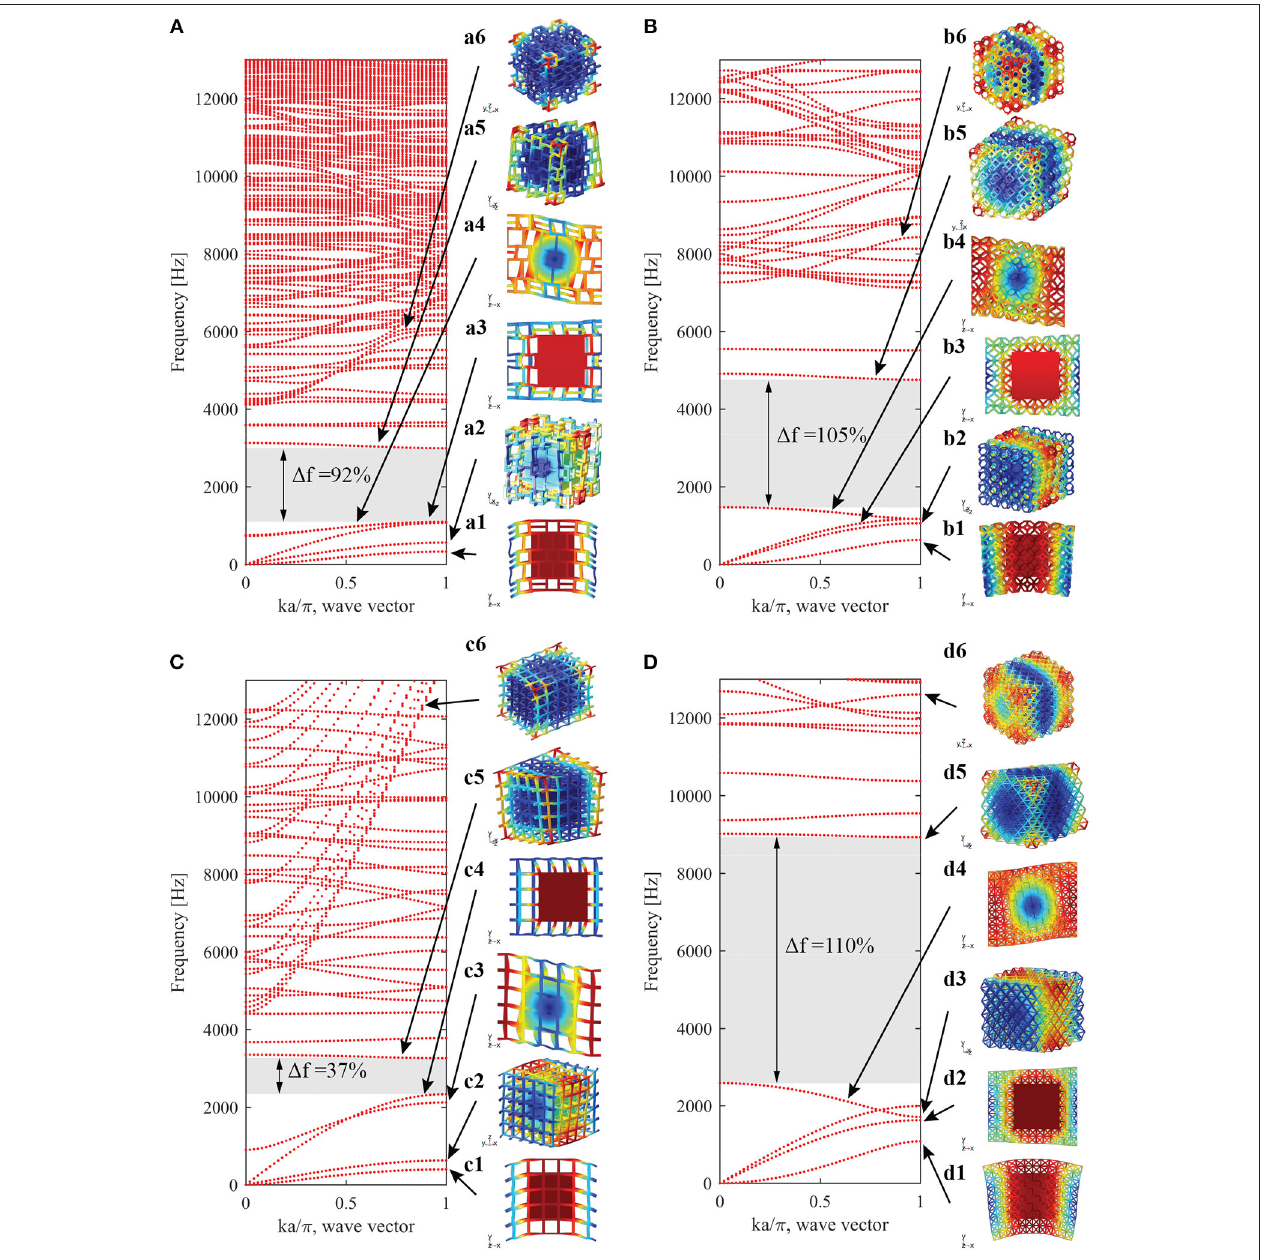
FIGURE 4 | Dispersion relations and modal displacement for the different metastructures with lattice relative density equal to 8.3%. (A) Idealized foam. (B) Kelvin. (C) Cubic (D) Octet. (Modal displacements are taken at ka/ π =